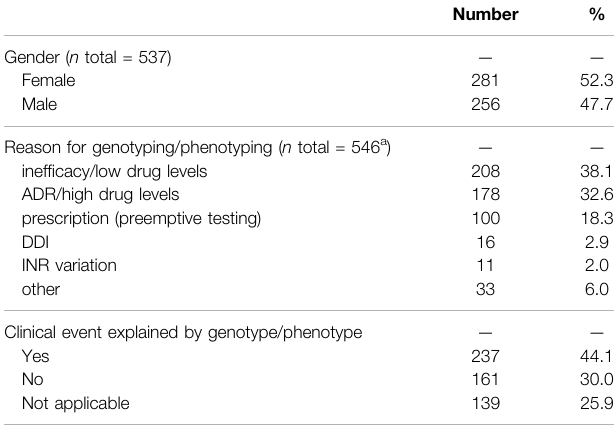
TABLE 5 | Characteristics of patients and reasons for